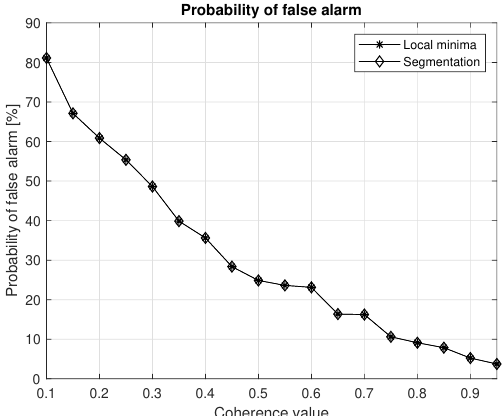
Figure 5: False alarm rate for the two techniques. The probability of false alarm is the same for the two methods since an absolute minima is always also a local